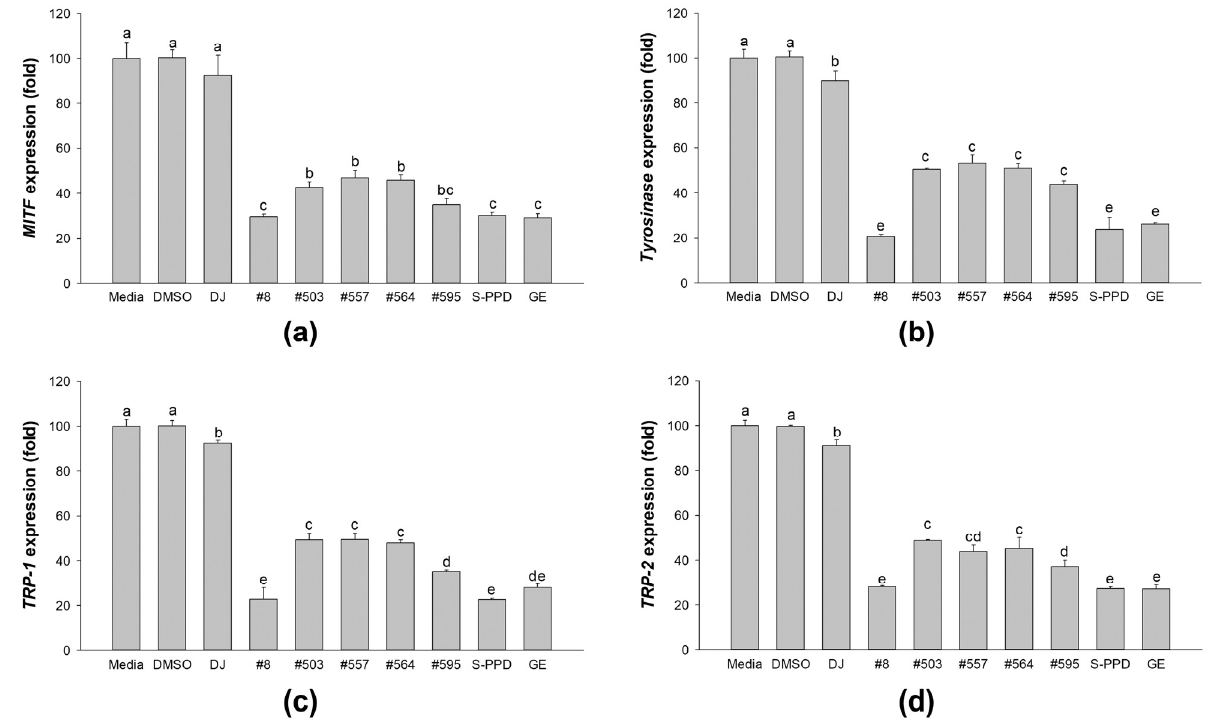
Figure 7. Effects of the PPD-enriched transgenic rice seed extracts on mRNA expression levels of melanogenesis mediators in melan-a cells. The expression levels of ( a ) MITF, ( b ) tyrosinase, ( c ) TRP-1, and ( d ) TRP-2. DJ, #8, #503, #557, #564, and #595 concentrations were 100 µg/mL. DMSO, S-PPD, and GE concentrations were 0.1%, 700 pg/mL, and 100 µg/mL, respectively. Data are shown as mean ± standard deviation ( n = 3). Lowercase letters indicate significant differences at p < 0.05 among the treatments.